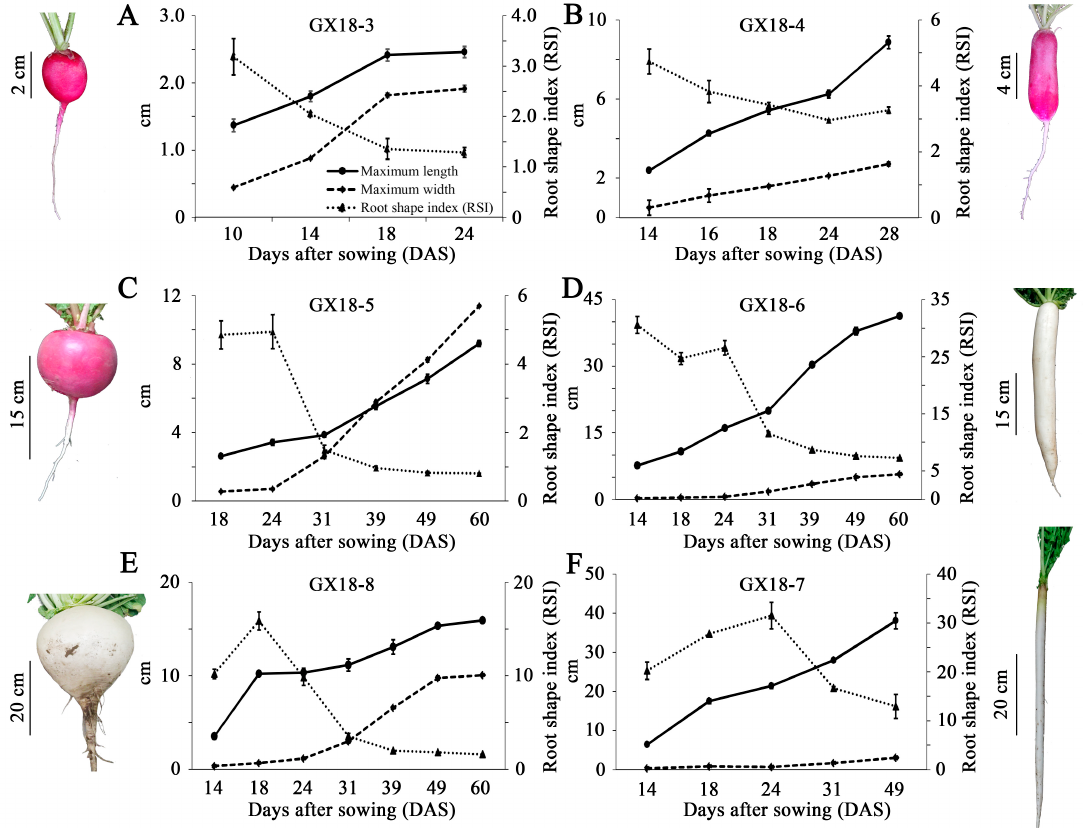
Figure 3. Growth parameters of six different radish cultivars during tuberous root development, including GX18 ‐ 3 ( A ), GX18 ‐ 4 ( B ), GX18 ‐ 5 ( C ), GX18 ‐ 6 ( D ), GX18 ‐ 8 ( E ), and GX18 ‐ 7 ( F ). Pictures of the radish cultivars are shown next to the plots. Error bars on each point indicate ±SE from at least three independent replicates.